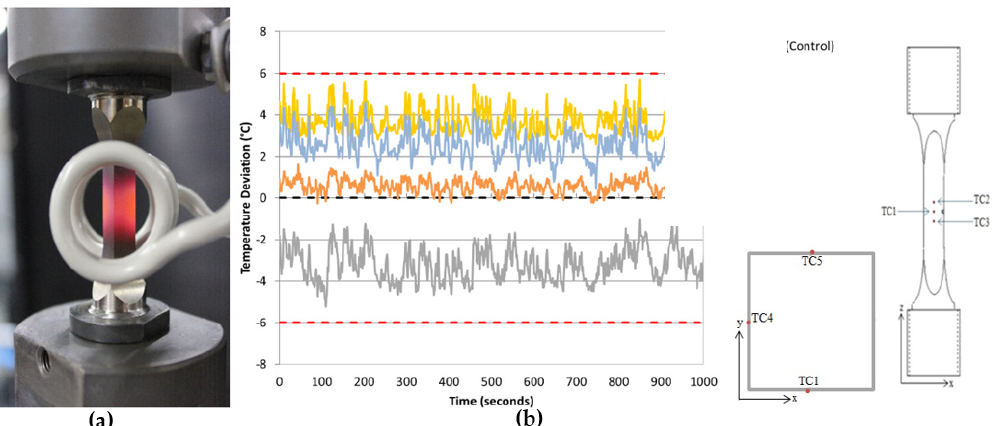
Figure 1. ( a ) Transversal field split helical coil ( b ) Temperature distribution associated with transversal field split helical coil, showing spread of ±6 °C in temperature across the critical volume of material around the crack and TC location, where TC2 and TC3 have been placed at ±5 mm from TC1 respectively, and TC4 and TC5 are placed to show effects at 90° and 180°, respectively [13] .